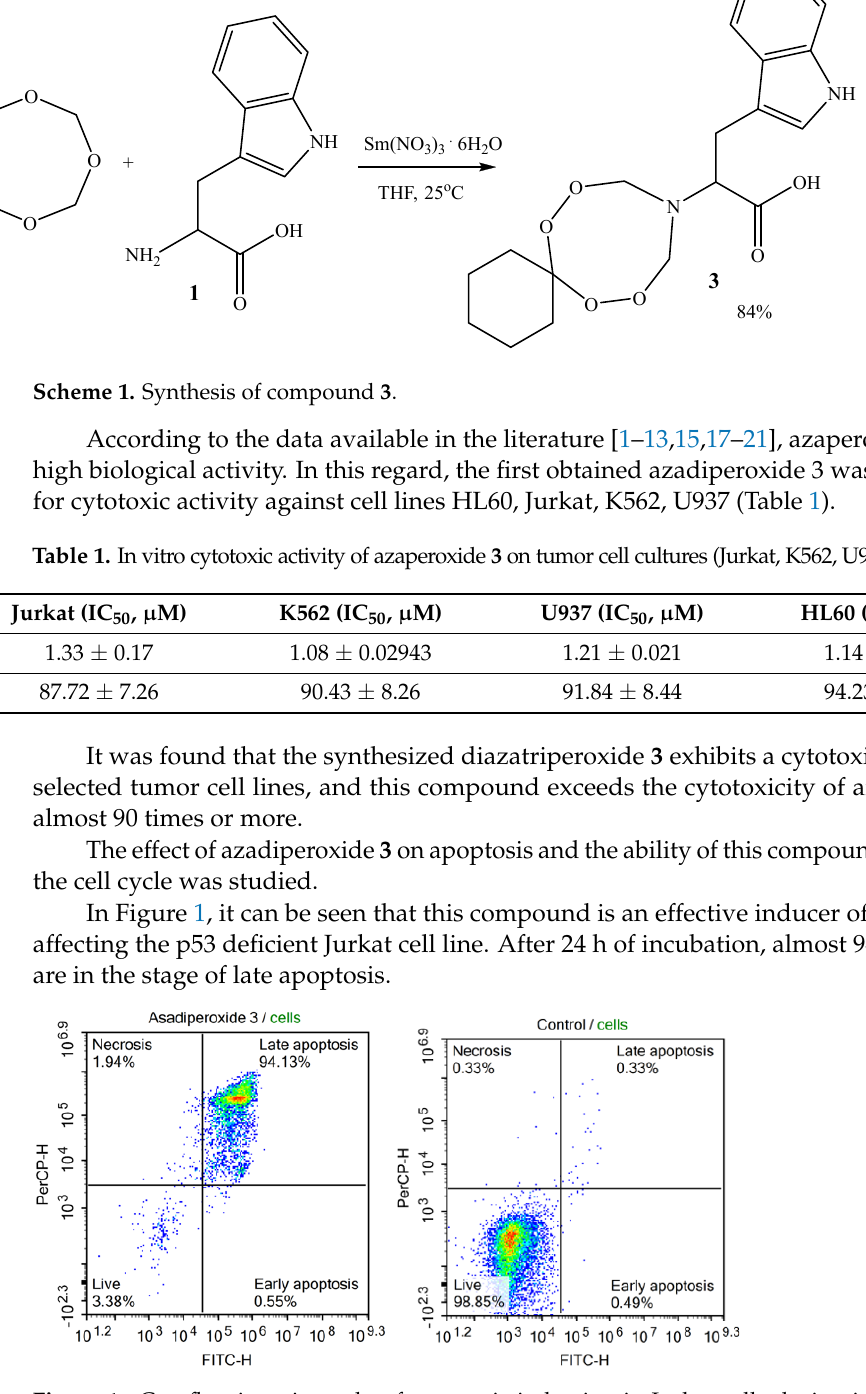
Figure 1. Cytofluorimetric study of apoptosis induction in Jurkat cells during incubation with azadiperoxide 3 at a concentration of 1.33 µ M for 24 h. Annexine Alexa Fluor 488 and 7AAD staining.